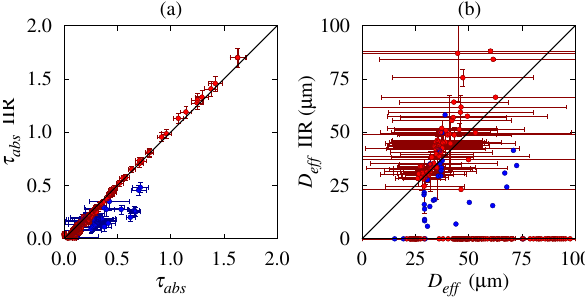
Fig. 6. Similar to Fig. 4, for 25 May 2007. A blue color indicates retrievals corresponding to pixels where a mid liquid water cloud was present in the cloud profile treated by our